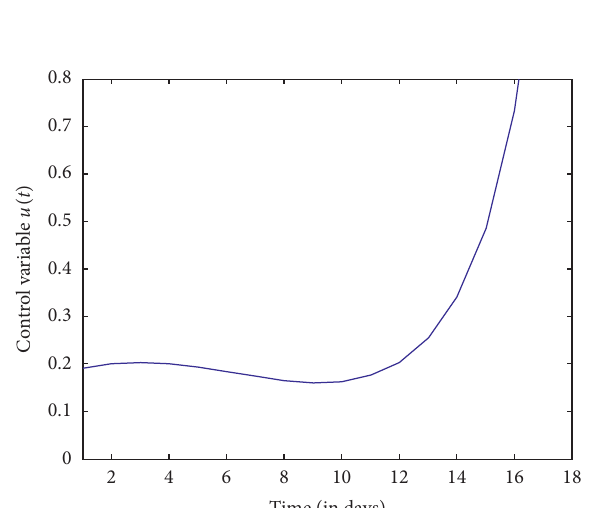
Figure 8: Error function.